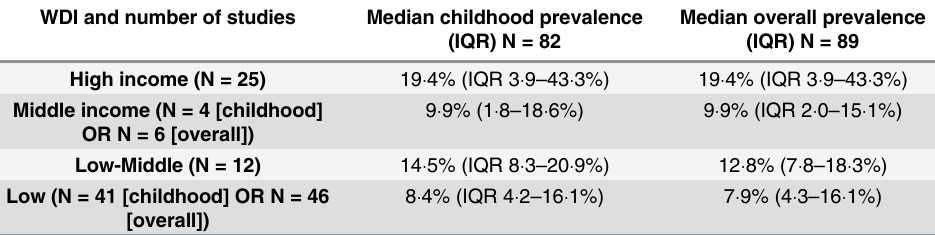
Table 5. Median prevalence of impetigo in childhood and overall, categorised by the World Develop- ment Index. WDI and number of studies